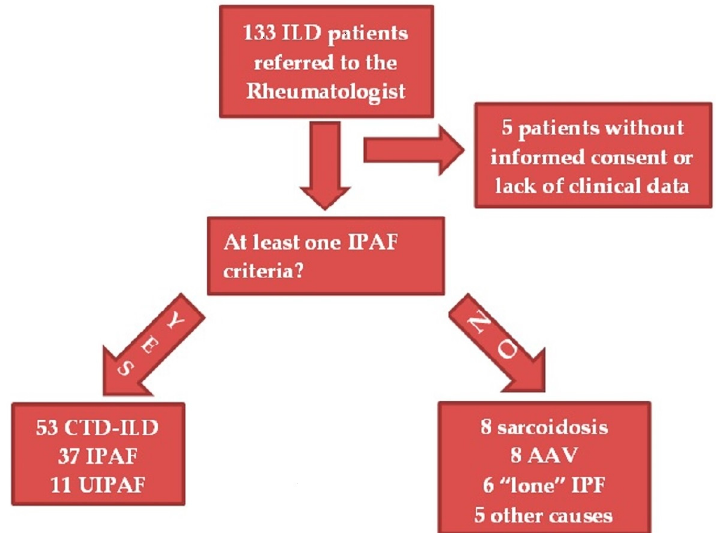
Figure 1. Patient classification. As “lone” IPF, we intended patients with IPF with clinical features due to a different condition (e.g., osteoarthritis) after rheumatological assessment (the so-called “lone” IPF). Legend: ILD, interstitial lung disease; IPAF, interstitial pneumonia with autoimmune features; CTD-ILD, connective tissue disease—interstitial lung disease; IPF, idiopathic pulmonary fibrosis; UIPAF, “usual” interstitial pneumonia with autoimmune features; AAV, anti-neutrophil cytoplasmic antibody (ANCA)-associated vasculitis.